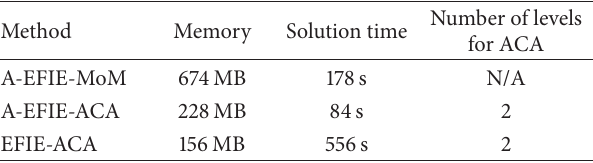
Table 2: The memory requirement and solution time in bistatic RCS computation for the